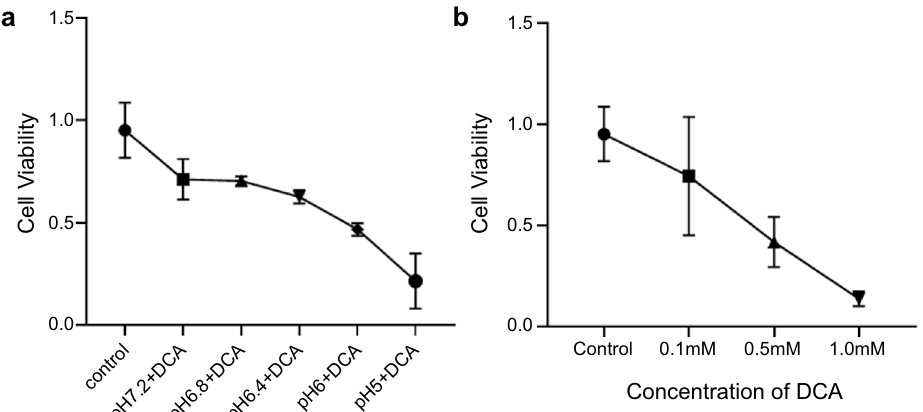
Figure 1. Cell viability of the OACP4C cell line under exposure of acids and deoxycholic acid. Cell viability of OACP4C cells treated at several pHs in combination with 100 μM deoxycholic acid (DCA) ( a ), and with several doses of DCA for 1 h ( b ). Approximately 50% cell viability was maintained in cell lines treated with acid at pH ≥ 6.4 in combination with 0.1 mM